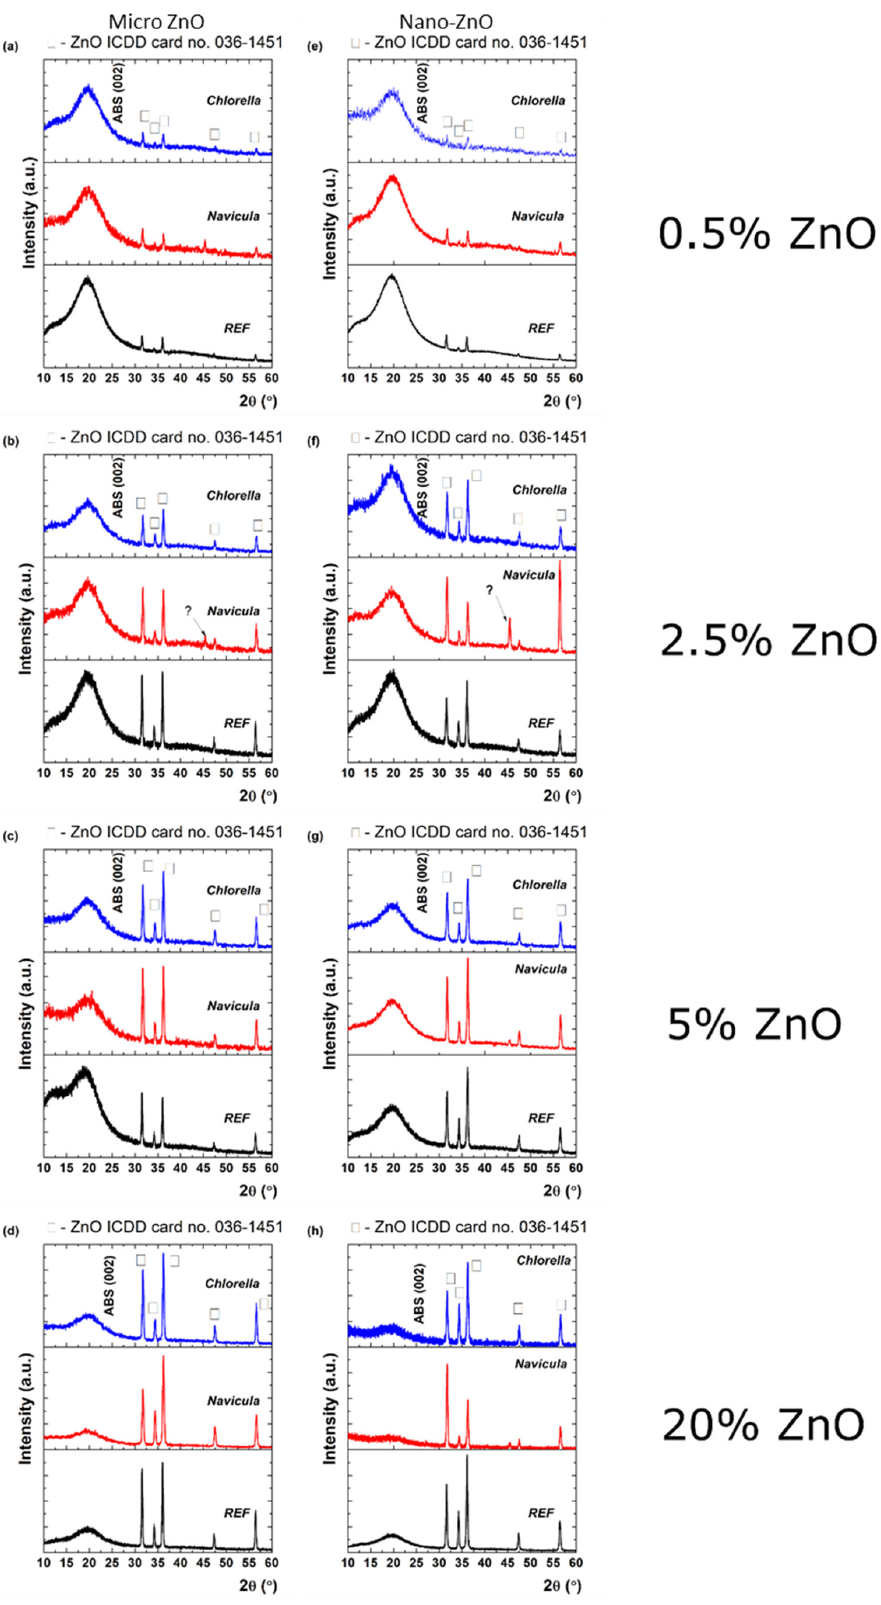
Figure 11. XRD patterns of micro- ( a – d ) and nano-ZnO-ABS ( e – h ) for the initial printed 3D grid (black) exposed to Navicula (red) and Chlorella (blue), respectively.